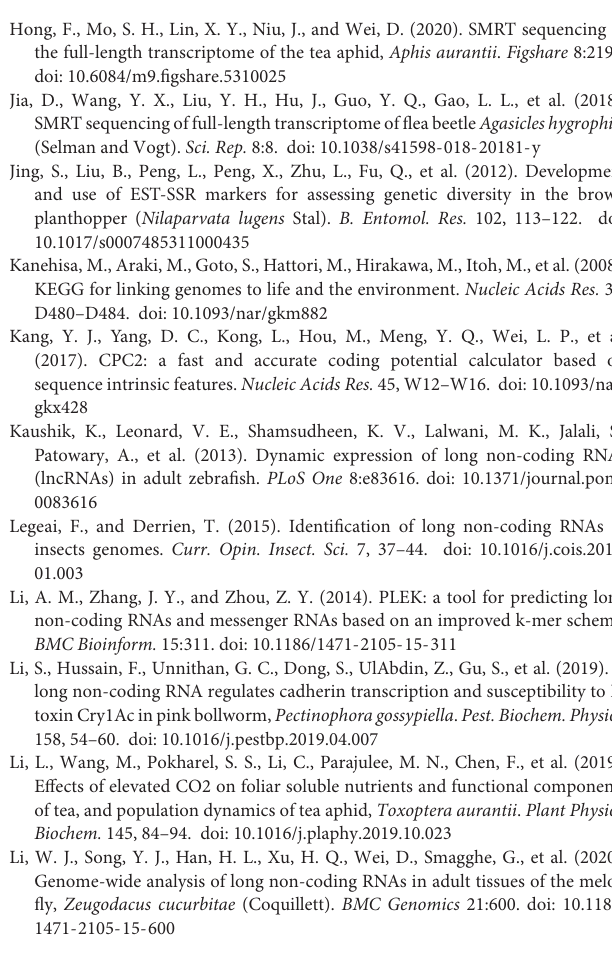
Supplementary Figure 1 | Read length distribution during the filtering process. (A) Polymerase reads length distribution. (B) Subreads length distribution. (C)